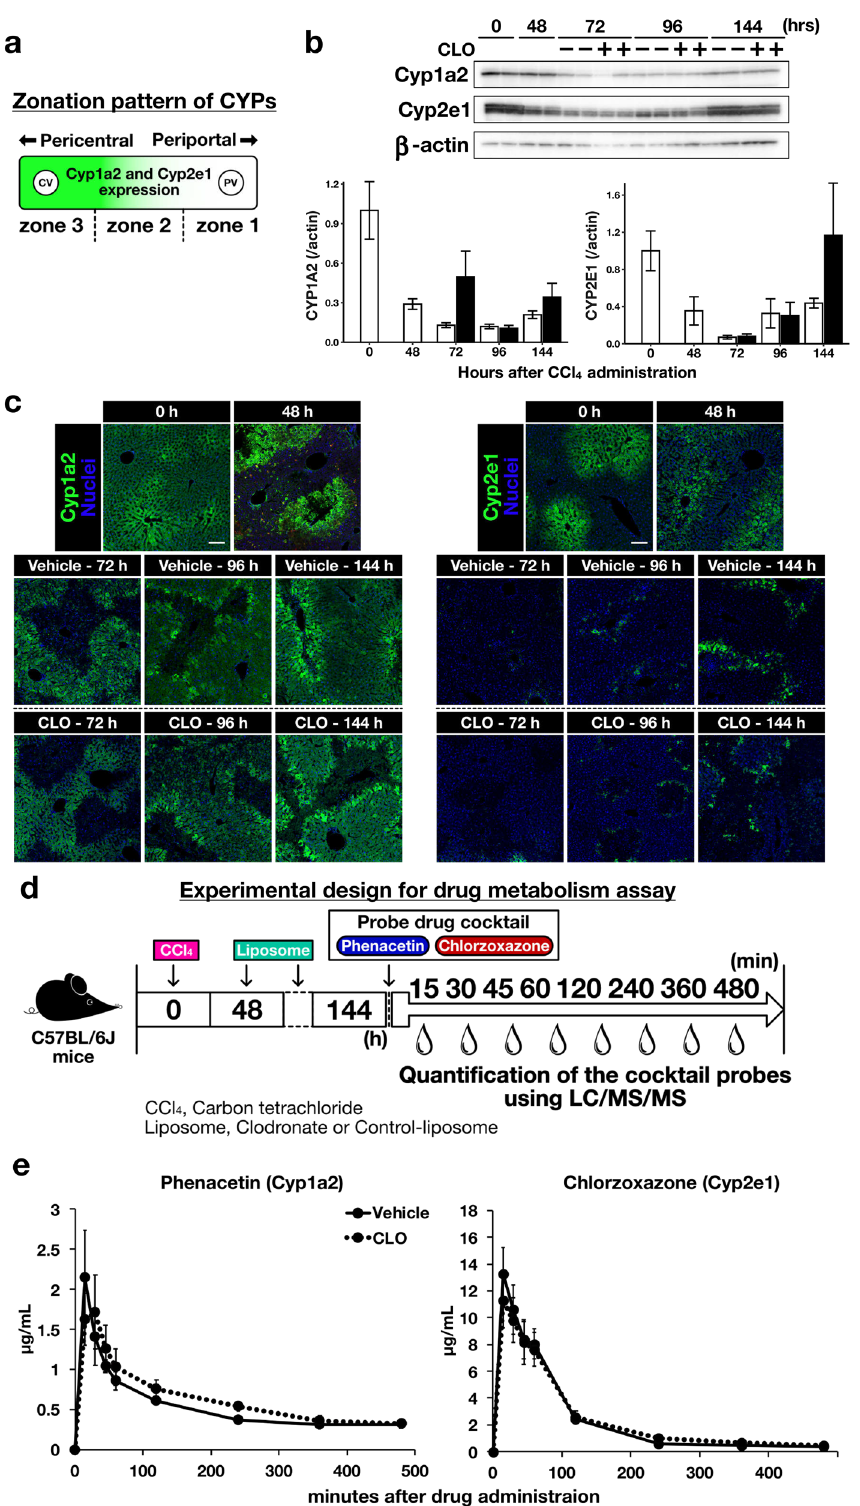
Figure 2. Effect of tissue remodelling suppression on drug metabolism during regeneration. ( a ) Zonation of cytochrome P450 enzymes (CYPs) in liver lobules. CYP expression by hepatocytes decreased gradually toward the periportal zones. Hepatocytes located in zone 1 of a healthy liver did not express CYPs. CV, central vein; PV, portal vein. ( b ) Cyp1a2 and Cyp2e1 protein expression levels measured by immunoblotting. β-actin was used as the loading control. ( c ) Representative immunofluorescent staining images of Cyp1a2 and Cyp2e1 (scale bar, 100 µm). Green, Cyp1a2 and Cyp2e1; blue, cell nuclei. ( d ) Experimental assessment of drug- metabolising capacity. C57BL/6 J mice were given CLO (100 µL/mouse, i.p. ) 48 h after CCl 4 (1.6 mL/kg b.w., p.o. ). These mice also received the probe drugs phenacetin and chlorzoxazone 144 h after CCl 4 administration. Blood samples were collected at 15, 30, 45, 60, 120, 240, 360, and 480 min after administration of the probes. The drug concentrations in plasma were quantified by LC/MS/MS. ( e ) Plasma concentration–time curves of phenacetin and chlorzoxazone. Solid lines denote vehicle-treated mice and dashed lines CLO- treated mice. Data are presented as mean ± SEM (n =